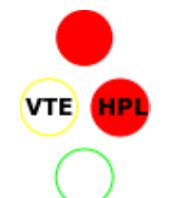
Figure 14. Alarm of GNSS fault — position or HPL not available, conceptual presentation in ECDIS.